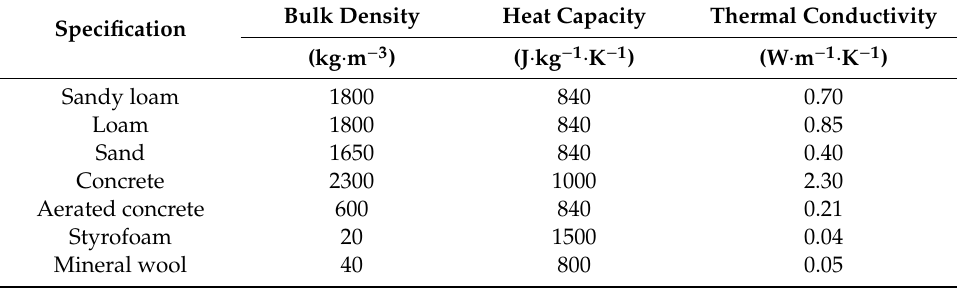
Table 1. Physical parameters of the soil and construction materials used in the